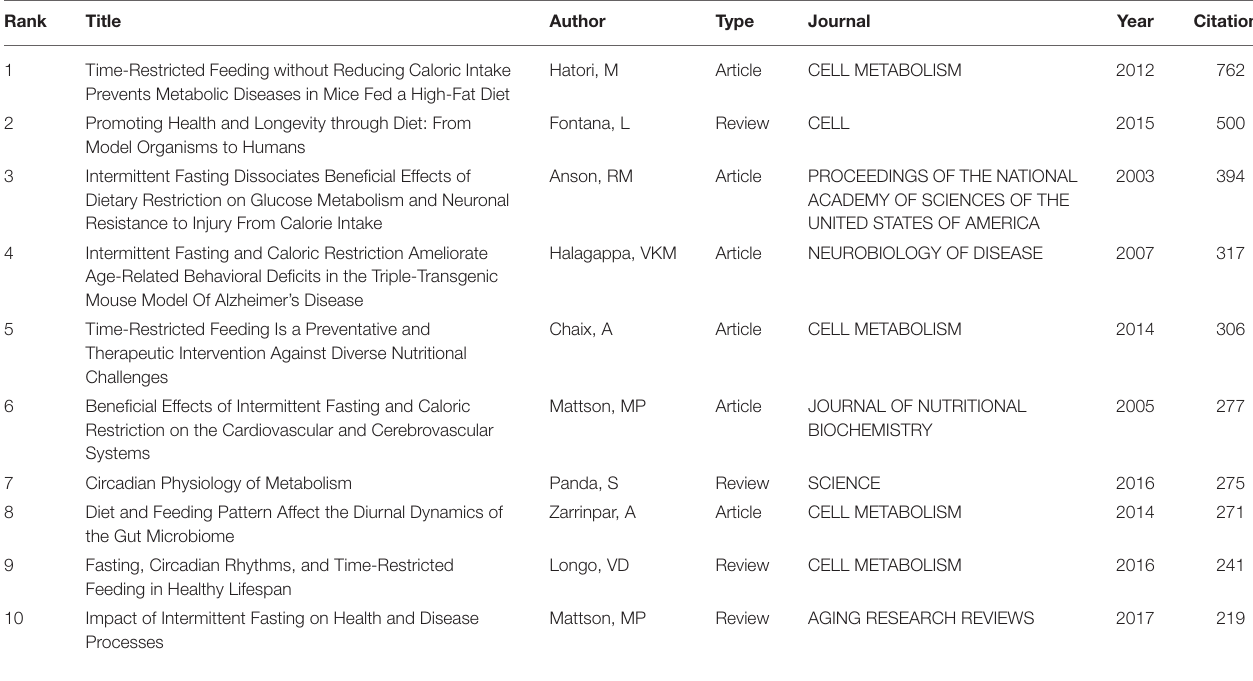
TABLE 5 | Top 10 papers with the most